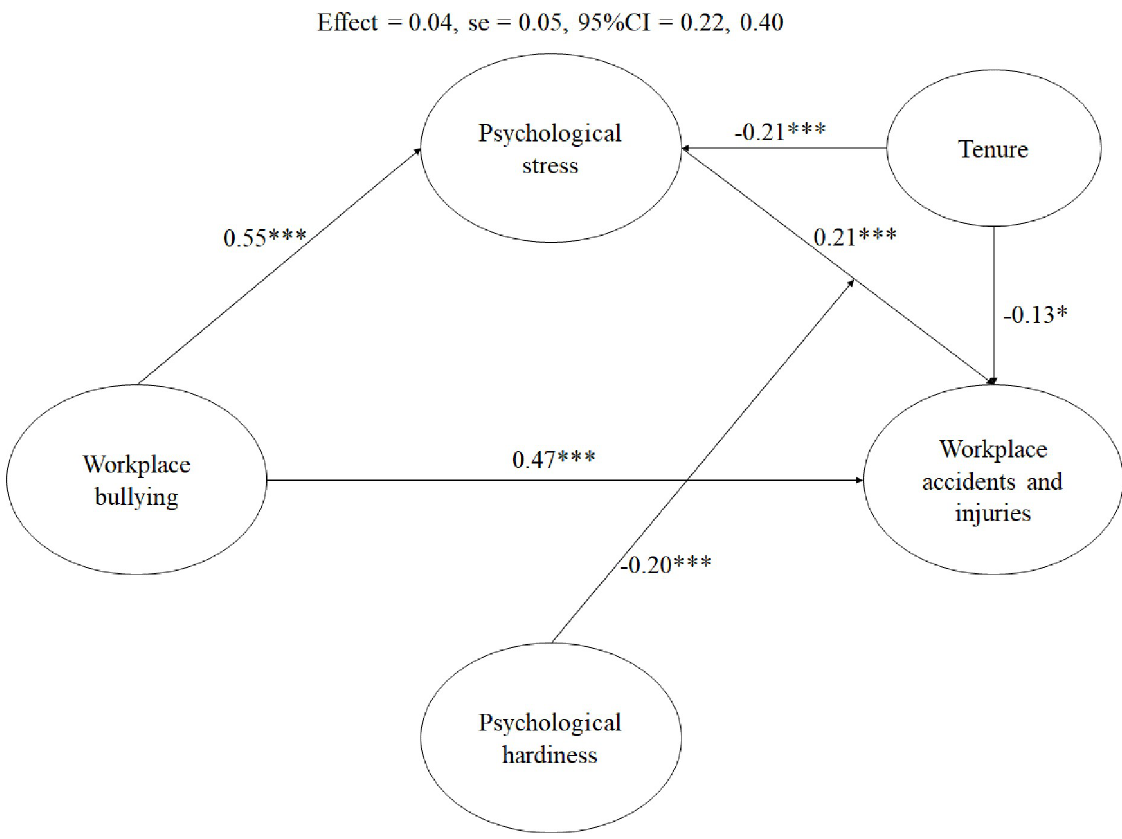
Fig 2. Results of hypotheses testing in Study 2. Note : N = 201, � p < 0.05, ��� p < 0.001.